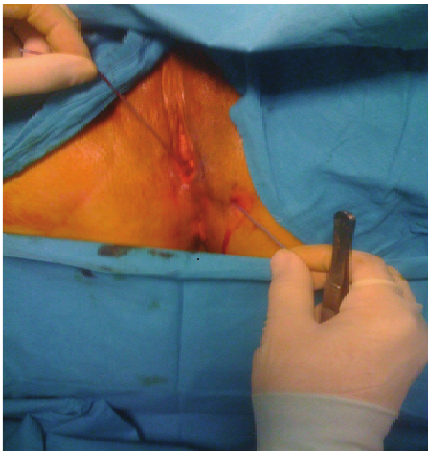
Figure 1: Vaginoperineal fistula.